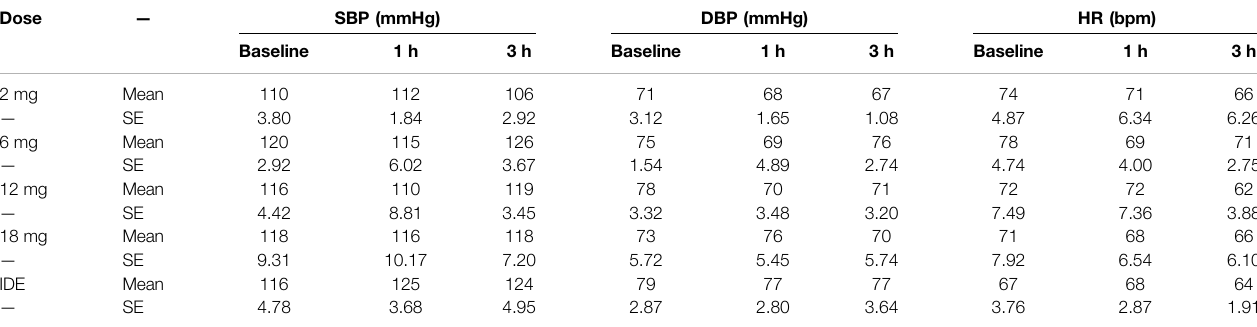
TABLE 2 | Mean (SE) systolic blood pressure (SBP), diastolic blood pressure (DBP and heart rate (HR) in every 5-MeO-DMT dose condition at baseline and 1 and 3 h after administration. IDE (cid:1) individualized dose escalation condition. Vital signs assessment in the 2 and 6 mg condition were deduced from continuous Caretaker